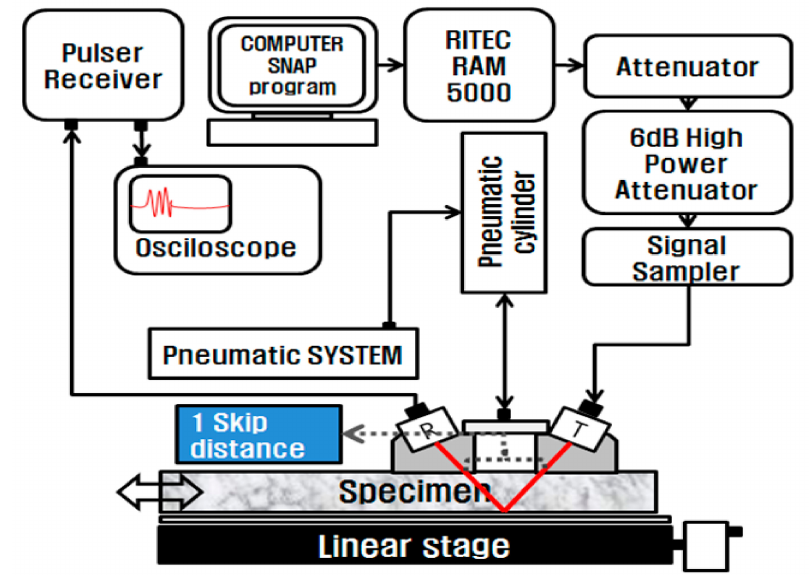
Figure 1. Schematic diagram of the experimental setup for measuring acoustic nonlinearity via the oblique incidence